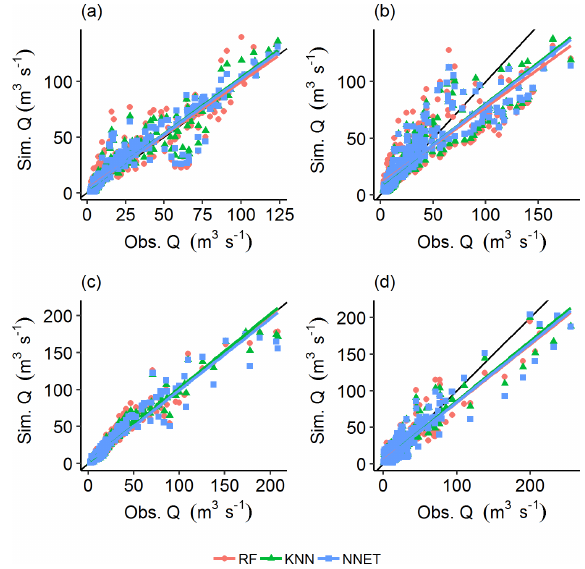
Figure 5. Scatter plots of simulated against observed streamflow values for the calibration period, i.e. year 2011 (a) , and validation periods, i.e. years 2012 (b) , 2013 (c) , and 2014 (d)